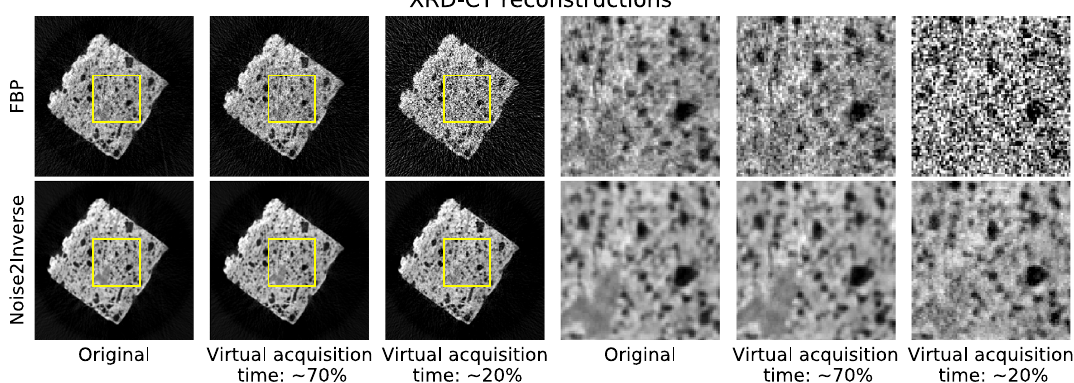
Figure 6. X-ray diffraction tomography reconstructions of a single channel of a single slice of a ceramic fragment. The leftmost column shows the reconstruction of the originally acquired data, and the next two columns show reconstructions with synthetic noise. The rightmost three columns show magnifications of the yellow region of interest.